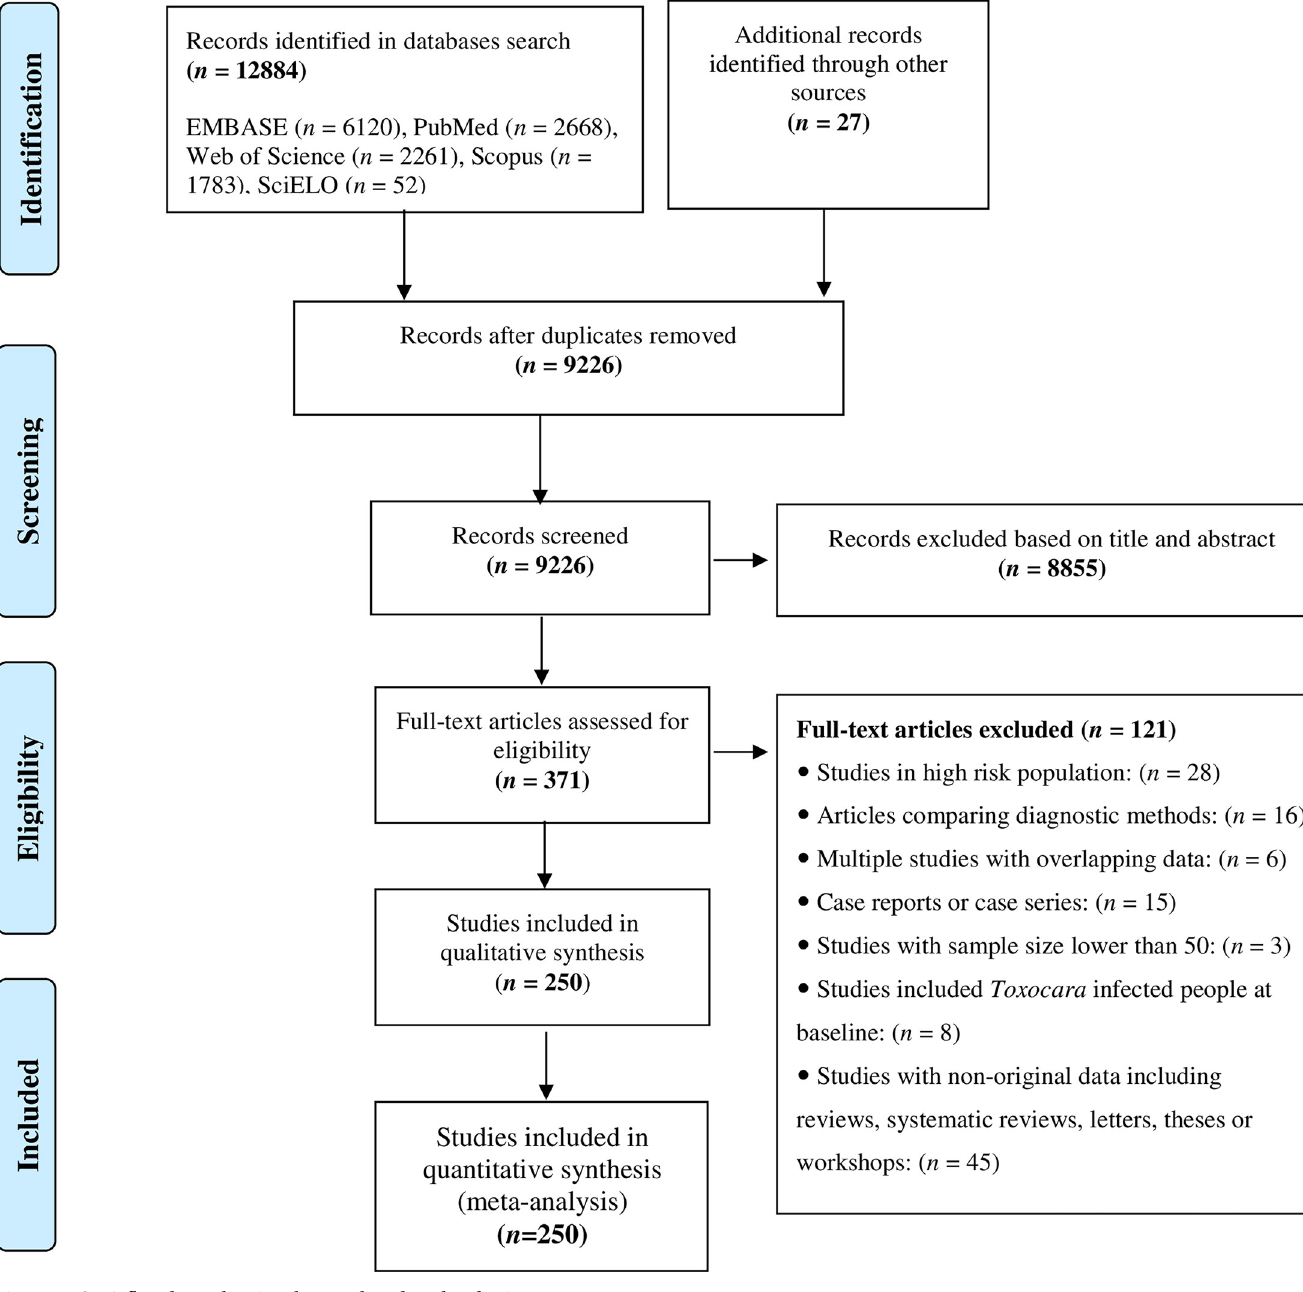
Fig 1. PRISMA flowchart, showing the search and study selection